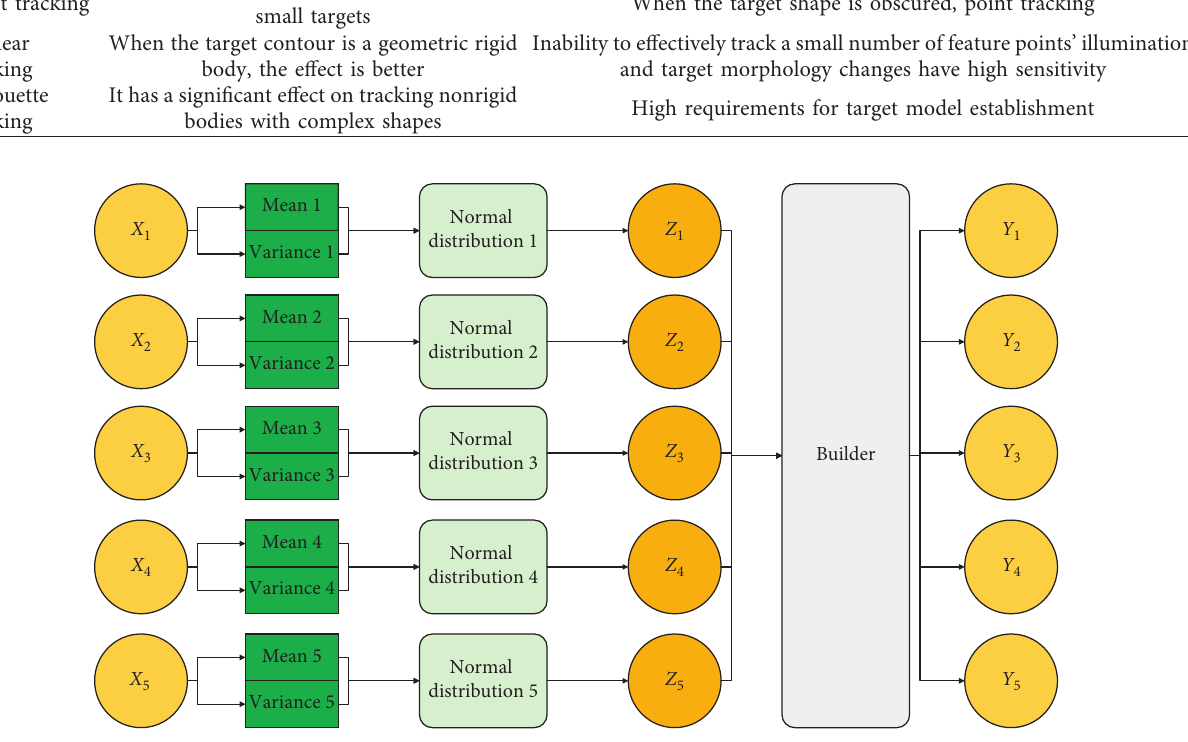
Figure 2: Working principle of the variable division self-encoder.